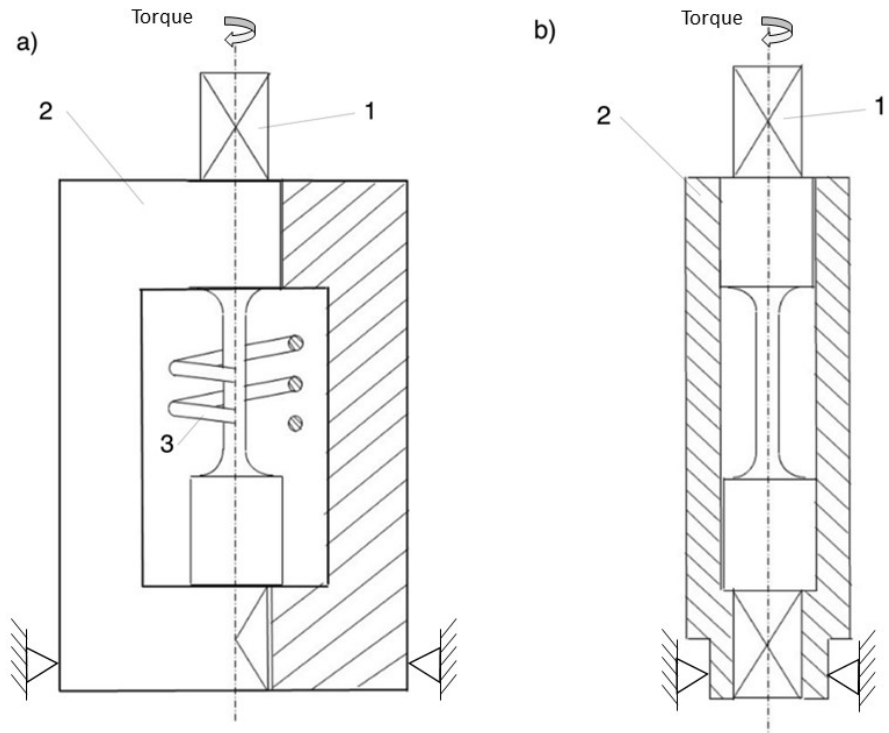
Figure 1. Two versions of setup for the determination of failure strain. Version ( a ) with an inductive heating coil (3) is suitable for elevated temperatures. Version ( b ) can be used for elevated, as well as lowered,